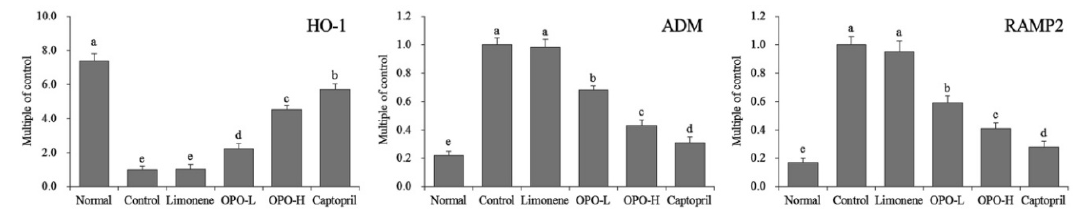
Figure 6. mRNA expression levels of HO-1, ADM and RAMP2 in rat myocardial tissue. For each group, n = 10 rats. a–e Bars with different letters in the chart are significantly different ( p < 0.05) according to Duncan’s multiple range test, and the same letter indicates that the values are not significantly different. OPO-L, orange peel oil low dose, 5 mL/kg bodyweight (bw); OPO-H, orange peel oil high dose, 10 mL/kg bw; captopril, 15.6 mg/kg bw; and limonene, 10 mL/kg bw.